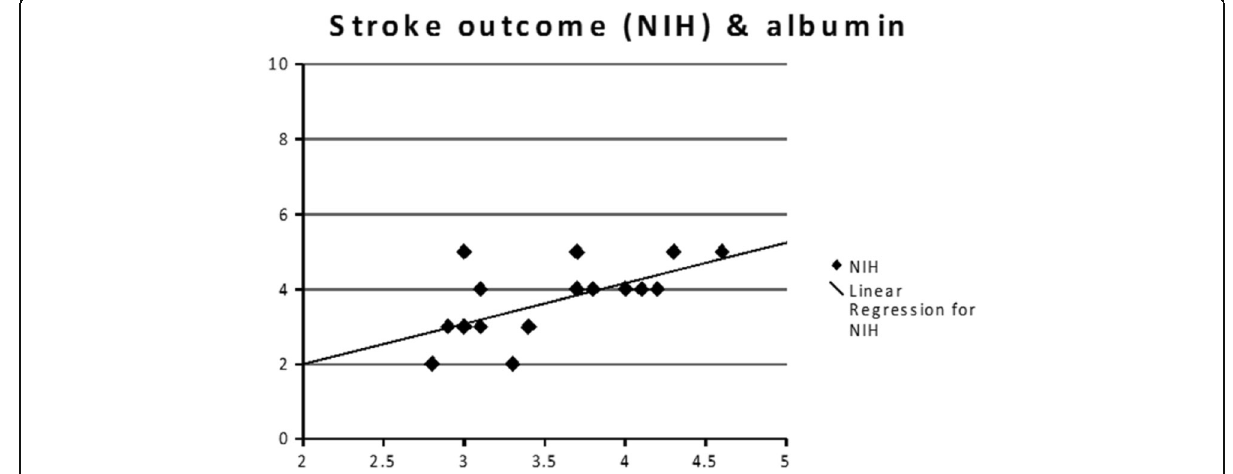
Fig. 1 Correlation between serum albumin and stroke